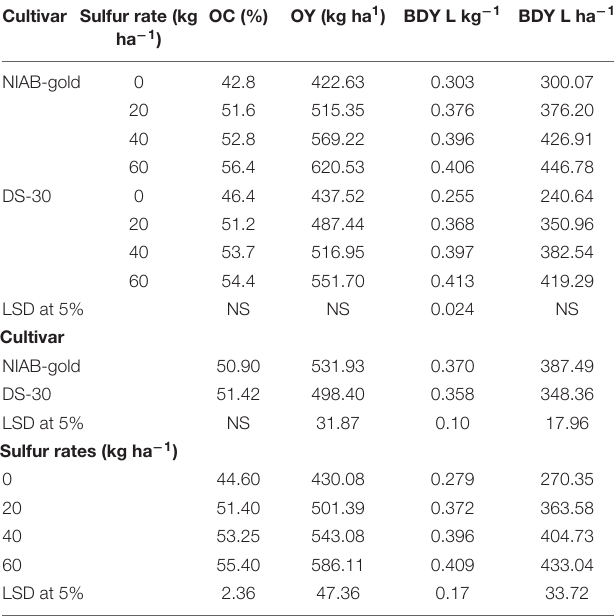
TABLE 6 | Effect of different cultivars and sulfur rates on oil content, oil yield, biodiesel yield kg − 1 seed, and biodiesel yield ha − 1 of castor bean. Cultivar Sulfur rate (kg ha − 1